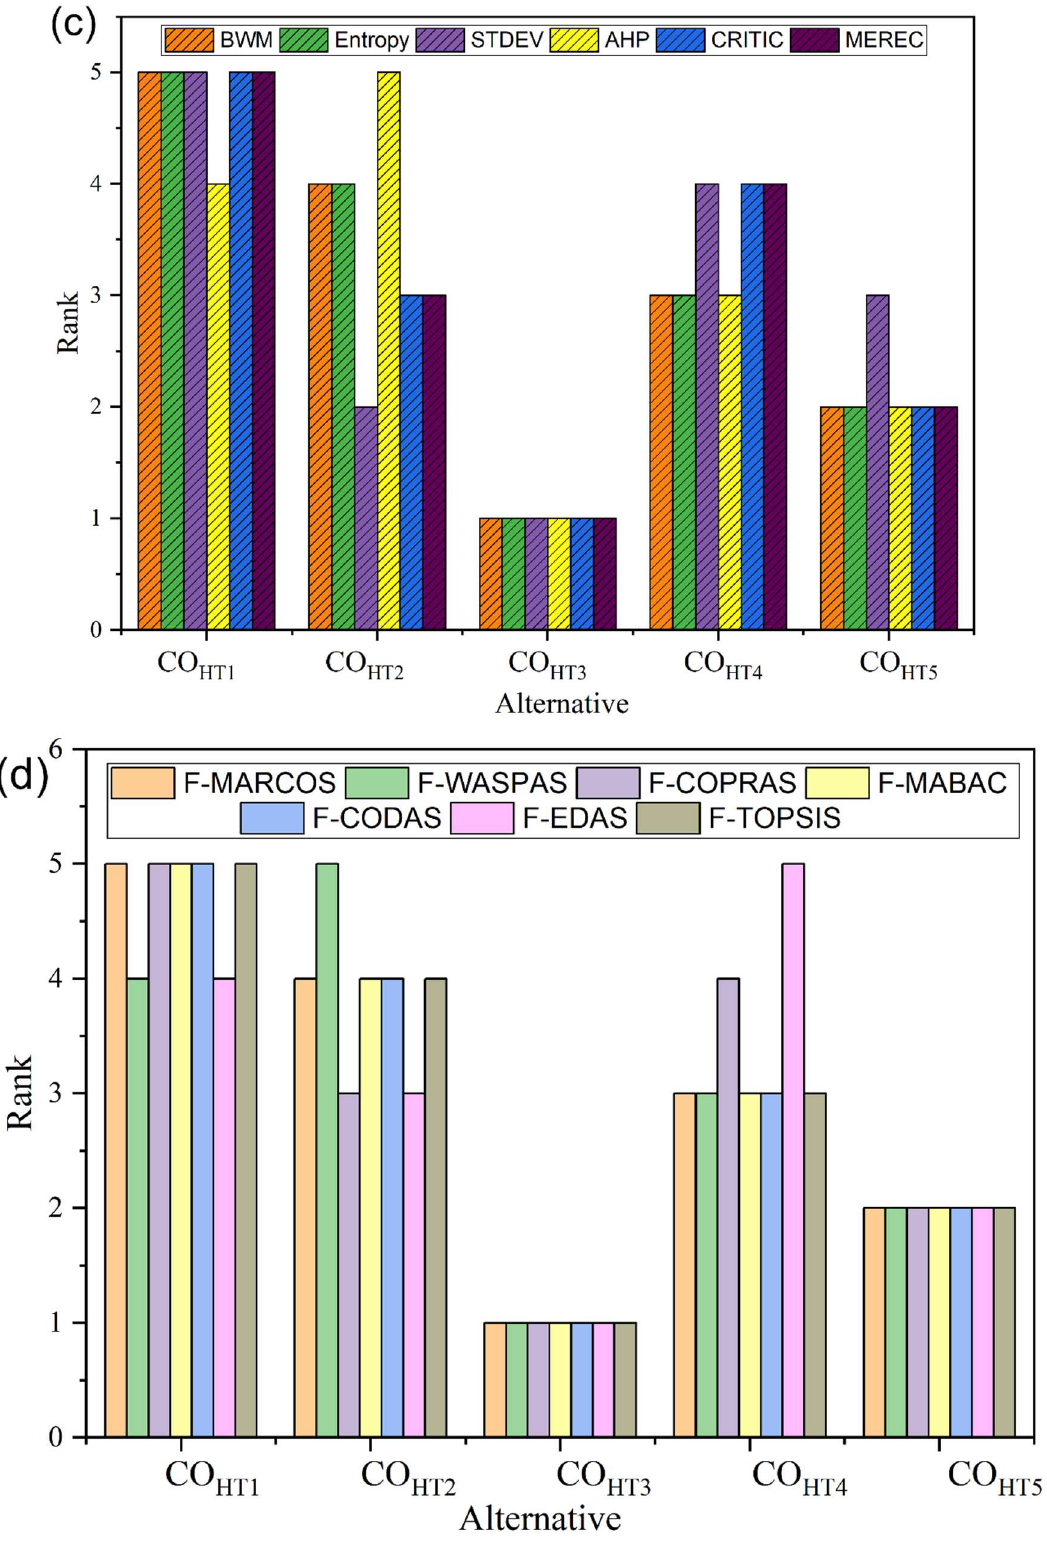
Figure 7. Consequences of ( a ) criteria weight change and ( b ) dynamic matrices, ranking of alternative derived from different ( c ) criteria weight change method and ( d ) other MADM approaches .